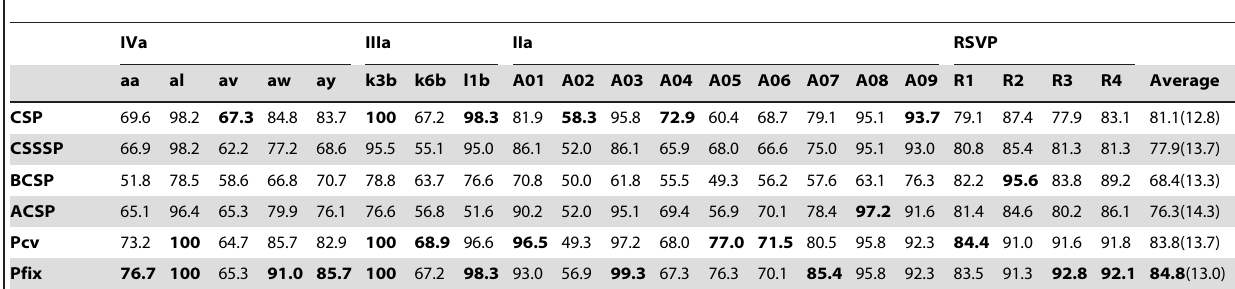
Table 2. Classification accuracies in % (standard deviation).